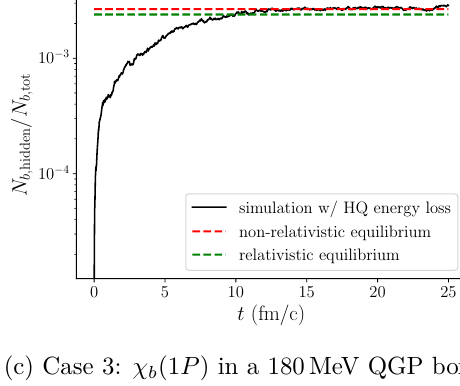
Figure 1. Comparison of the hidden bottom fraction between simulations and properties in thermal equilibrium. The system approaches equilibrium due to the interplay between quarkonium dissociation and